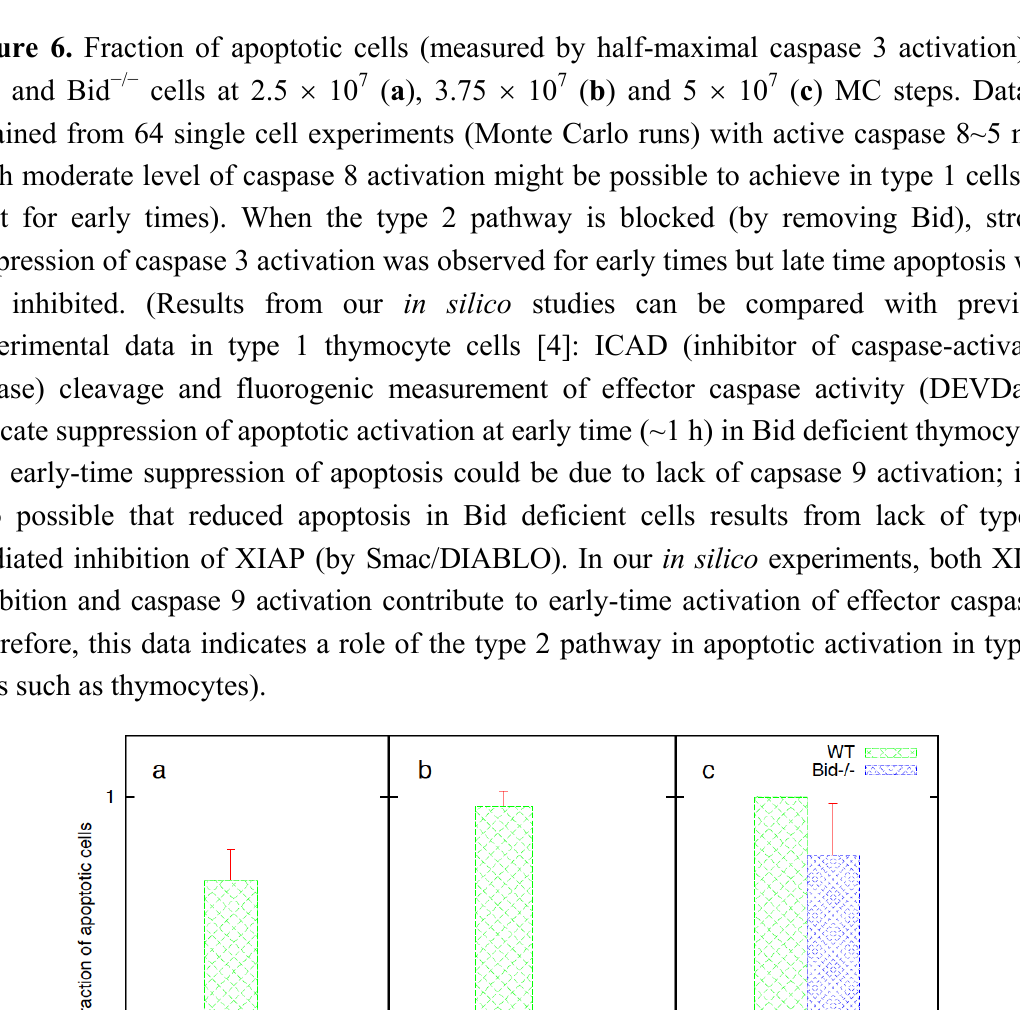
Figure 6. Fraction of apoptotic cells (measured by half-maximal caspase 3 activation) in WT and Bid −/− cells at 2.5  10 7 ( a ), 3.75  10 7 ( b ) and 5  10 7 ( c ) MC steps. Data is